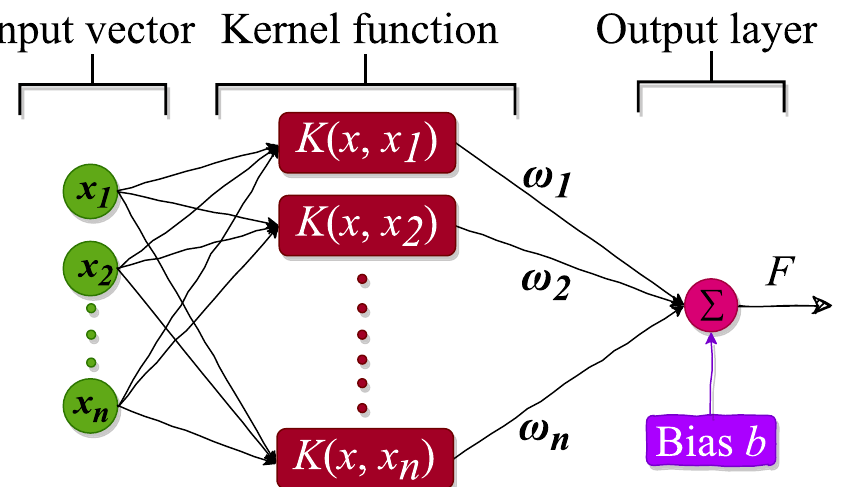
Fig. 1 The network structure of the SVR